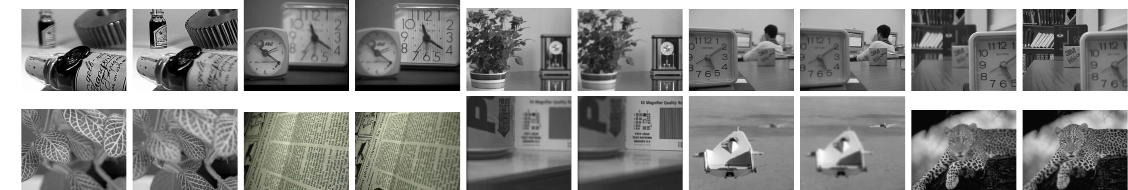
Figure 3. Sample multi-focus images from Grayscale dataset.